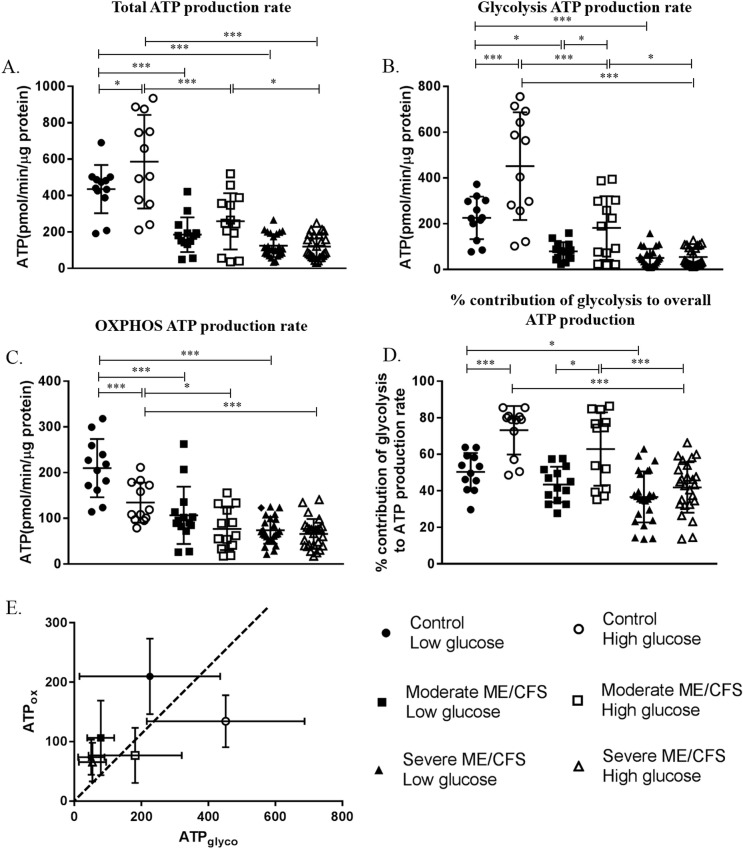
ATP-linked respiration rates in PBMCs from healthy controls and moderately and severely affected ME/CFS patients in low (1mM) and high (10mM) glucose conditions.(A) Total ATP-linked respiration rate. (B) Glycolysis ATP-linked respiration rate. (C) OXPHOS ATP-linked respiration rate. (D) % contribution of glycolysis to overall ATP-linked respiration rate. (E) Each group plotted as ATP produced via glycolysis (ATPglyco) against ATP produced via OXPHOS (ATPOX). The dotted line represents equal production of ATP from glycolysis and OXPHOS. Groups to the right of the line are primarily glycolytic (>50% of ATP derived from glycolysis pathway) while groups to the left of the line use OXPHOS as the primary pathway for ATP-linked respiration (>50% of ATP produced via OXPHOS). Groups were compared using two-way ANOVAs with post-hoc Bonferroni correction. Healthy controls low glucose n = 12; Healthy controls high glucose n = 12; moderately affected ME/CFS low glucose n = 14; moderately affected ME/CFS high glucose n = 13; severely affected ME/CFS low glucose n = 25; severely affected ME/CFS low glucose n = 25. *p≤0.01; ***p≤0.001.